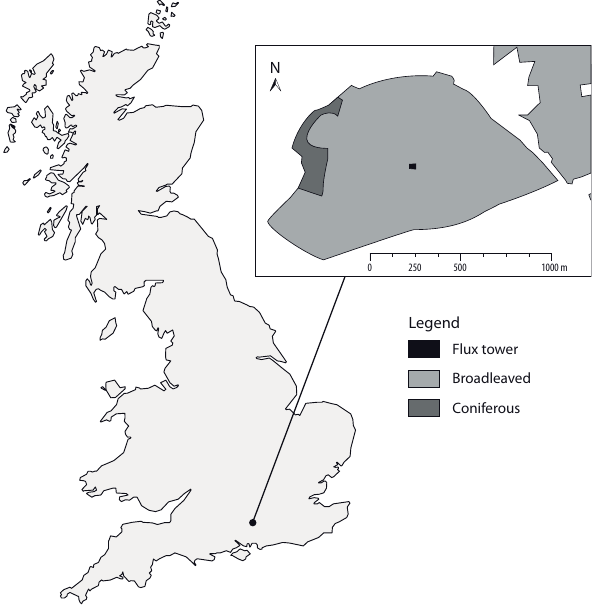
Fig. 1. Map of Great Britain with inset figure showing the location and layout of the Straits